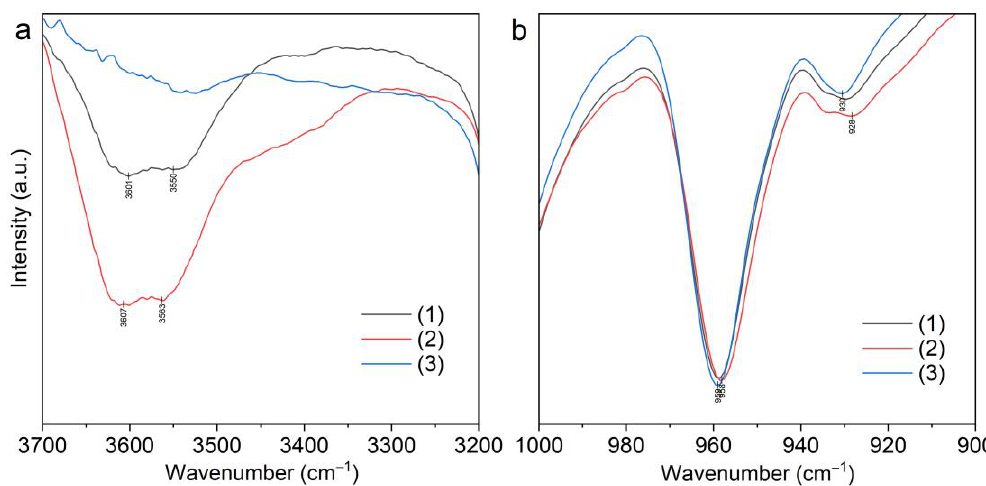
Figure 16. Fragments of FTIR spectra in the ranges of 3700 – 3200 cm −1 ( a ) and 1000 – 900 cm −1 ( b ): (1) solution of the complex (I) in [C8mim][NTf 2 ] (0.5 mol/L); (2) extract of LiNTf 2 -B15C5 (0.5 mol/L)-[C8mim][NTf 2 ]; (3) extract of LiCl-B15C5 (0.5 mol/L)-[C8mim][NTf 2 ].